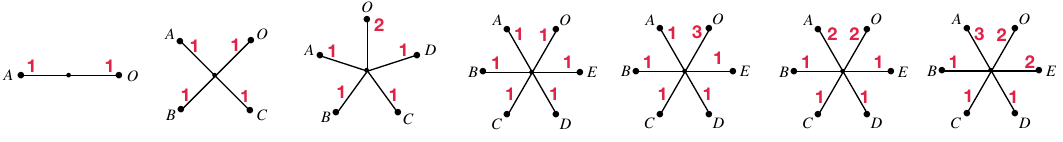
Figure 2 . Graphs models of extreme vectors of the N = 5 holographic entropy cone, which are used in section 3.4. The graphs were drawn following